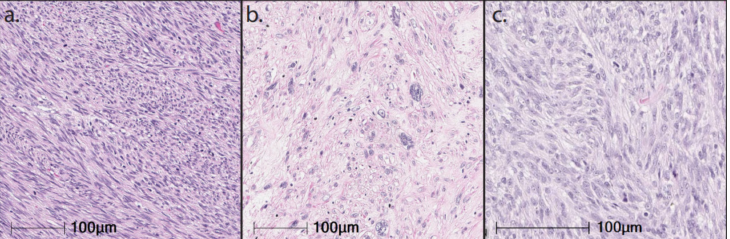
Figure 1. Hematoxylin-and-eosin slides of different leiomyosarcoma subtypes at 20 × magnification. ( a ) Well-differentiated soft tissue leiomyosarcoma; ( b ) Dedifferentiated soft tissue leiomyosarcoma; ( c ) Uterine